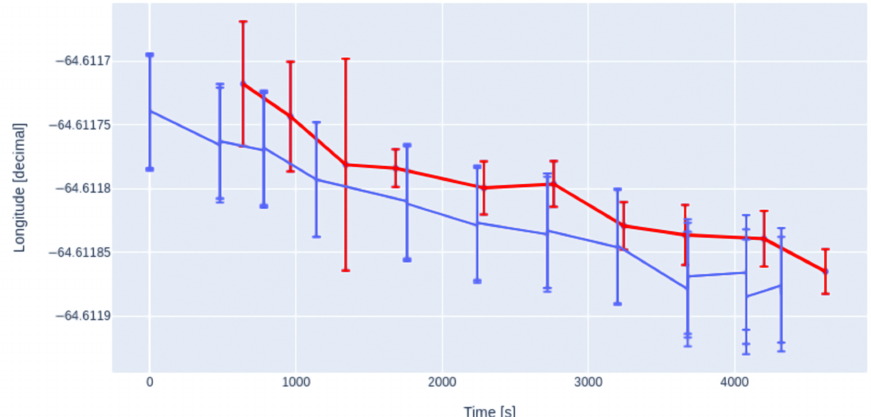
Figure 7. Longitude measured with a handheld Garmin GPS (blue) overlapped with the same positions measured with the GPS of the MD (red), at the same positions plotted in Figure 5. The error bars represent the measurement errors as explained in the text for each